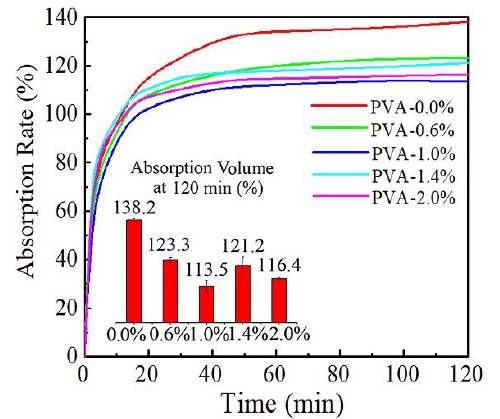
Figure 8. Swelling behavior of pure PVA membranes and PVA membranes with various contents of ferric ions.